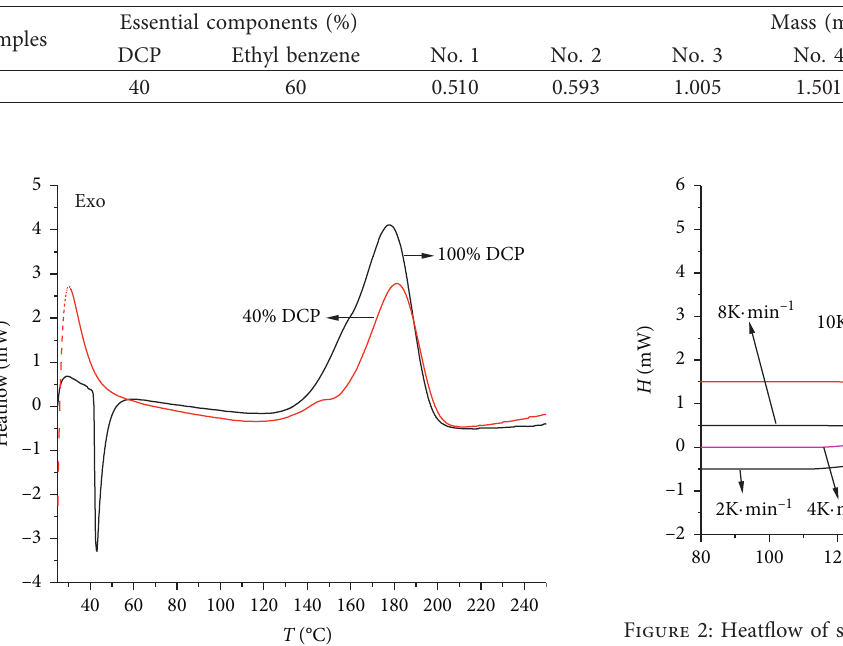
Table 2: Mass in ARC tests.